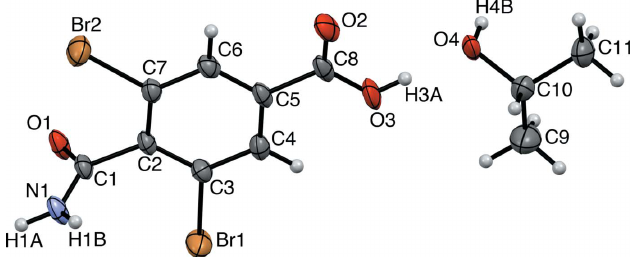
Figure 2 The molecular structure of (I), with atomic numbering and displacement ellipsoids at the 50% probability level. For clarity, only the major disorder component of 2-propanol is